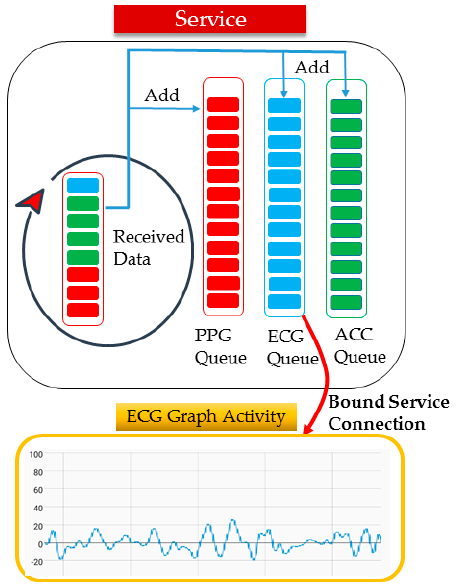
Figure 11. Software structure of mobile app.